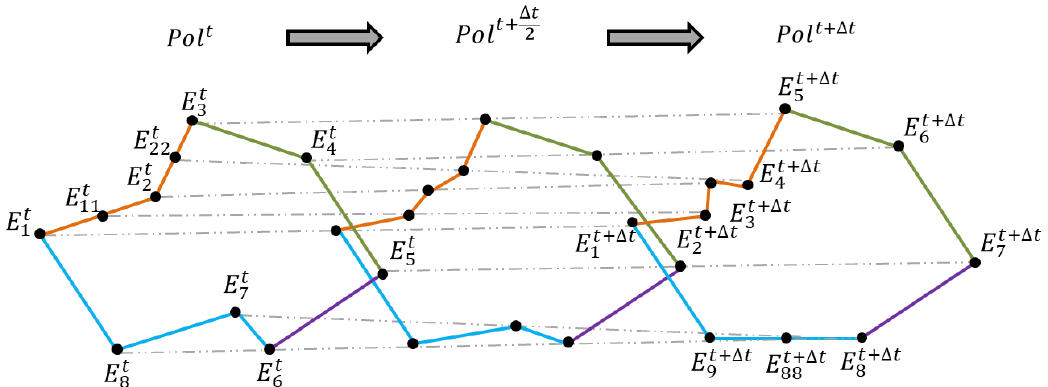
𝑡 0 accordingly to accordingly 2 2